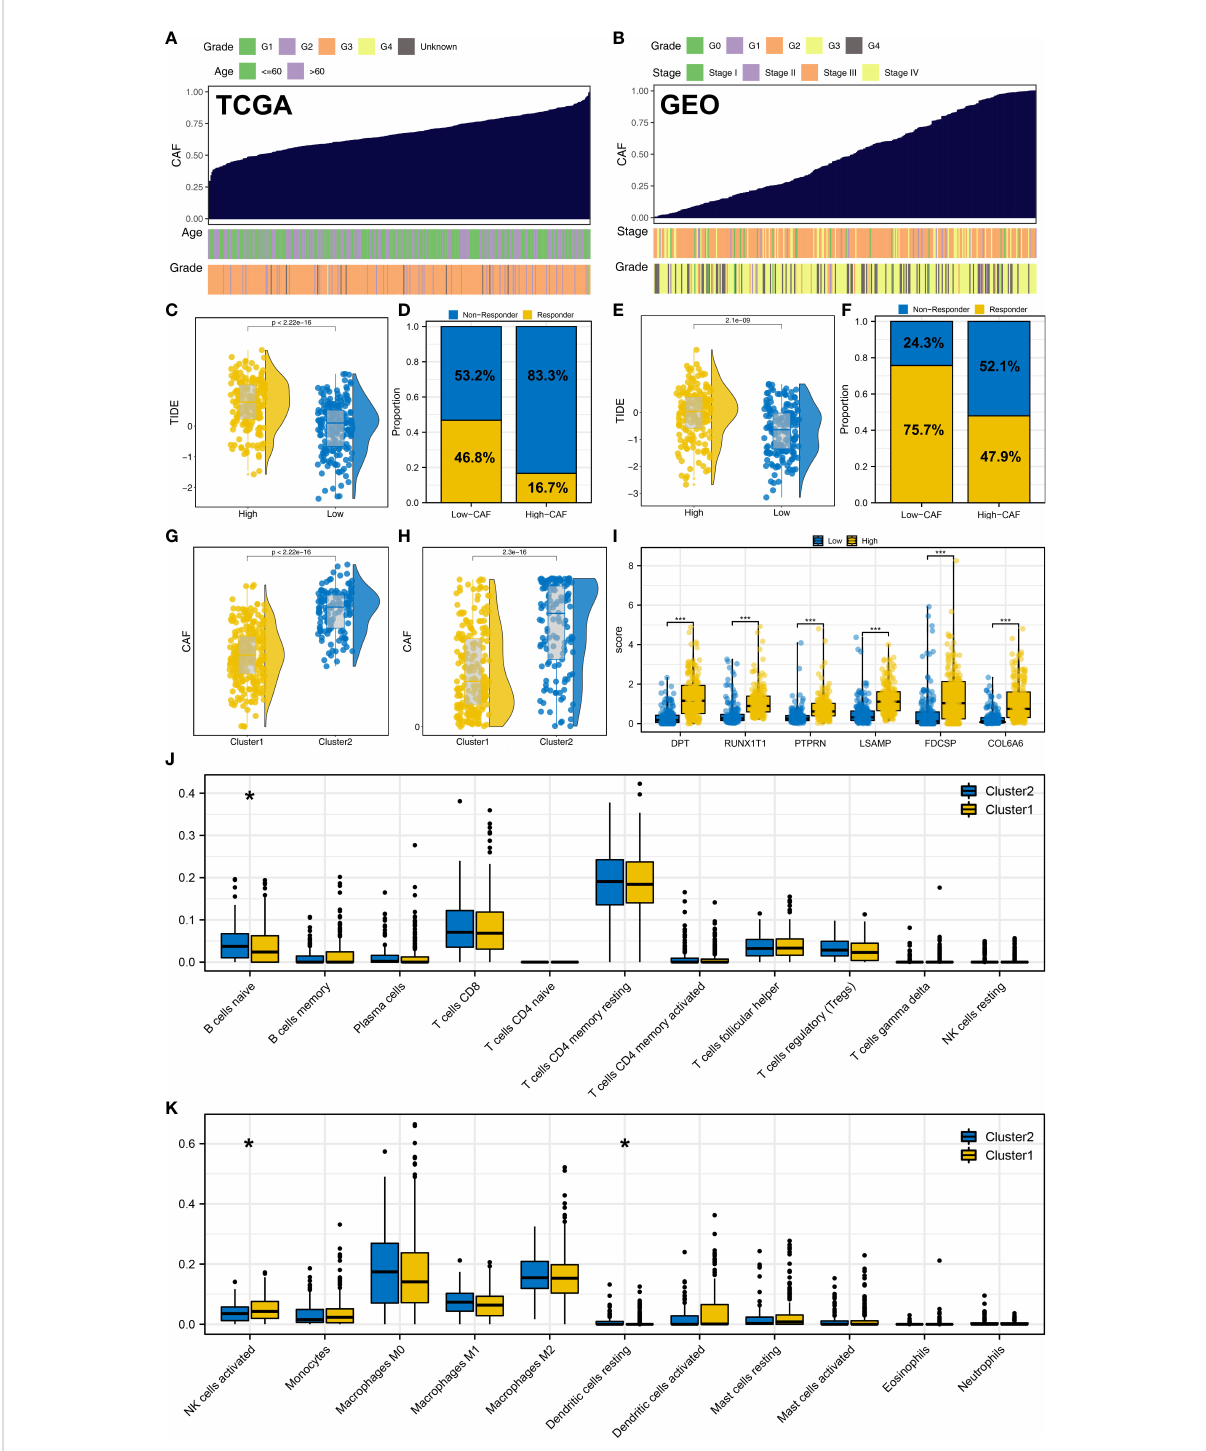
FIGURE 8 CAFs is associated with the immunotherapy response of OC. (A, B) ssGSEA algorithm was used to quantify the CAFs in fi ltration in TCGA and GSE cohorts; (C, D) In TCGA, patients with low CAFs in fi ltration had a lower TIDE score and a higher proportion of immunotherapy responders; (E, F) In the GEO cohort, patients with low CAFs in fi ltration had a lower TIDE score and a higher proportion of immunotherapy responders; (G) In TCGA, patients in Cluster2 had a higher CAFs in fi ltration; (H) In the GEO cohort, patients in Cluster2 also had a higher CAFs in fi ltration; (I) DPT, RUNX1T1, PTPRN, LSAMP, FDCSP and COL6A6 were upregulated in the patients with high CAFs in fi ltration; (J, K) Immune in fi ltration analysis of Cluster1 and Cluster2. * = P < 0.05, *** = P <